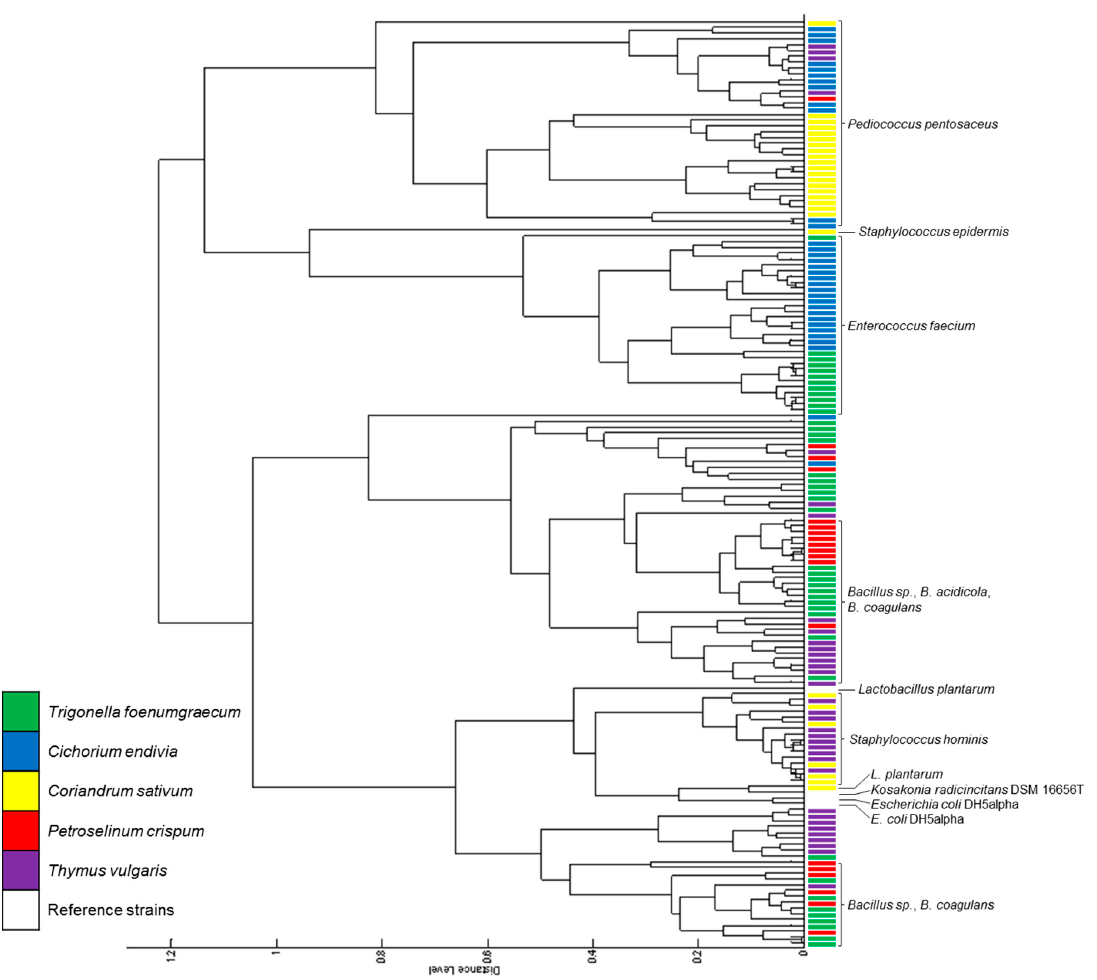
Figure 3. Cluster analysis of bacterial mass spectra obtained from selected reference strains and plant isolates. The latter are labeled in color according to the plant host. The identification of major isolate groups is shown on the right. Distance is displayed in relative units. For the full list of identified isolates, please refer to Supplemental Table S1.